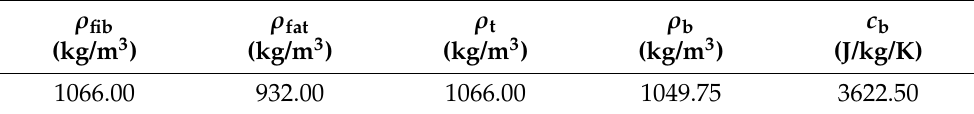
Table 2. Quantities considered for converting blood perfusion rate units to the SI units. ρ fib , ρ fat , ρ t , and ρ b are the density of fibroglandular breast, fatty breast, breast tumour, and blood, respectively. c b is the specific heat capacity of